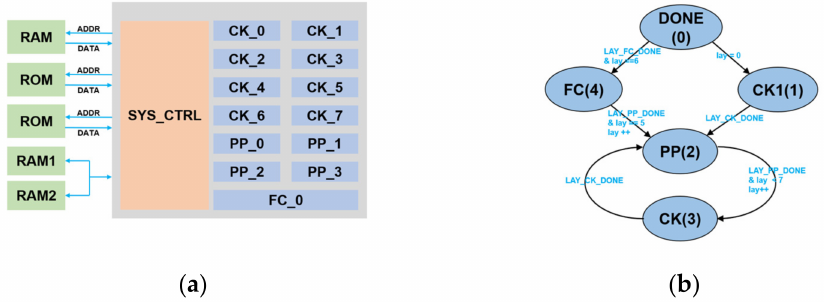
Figure 11. ( a ) CNN accelerator structure. ( b ) State transition diagram of controller.